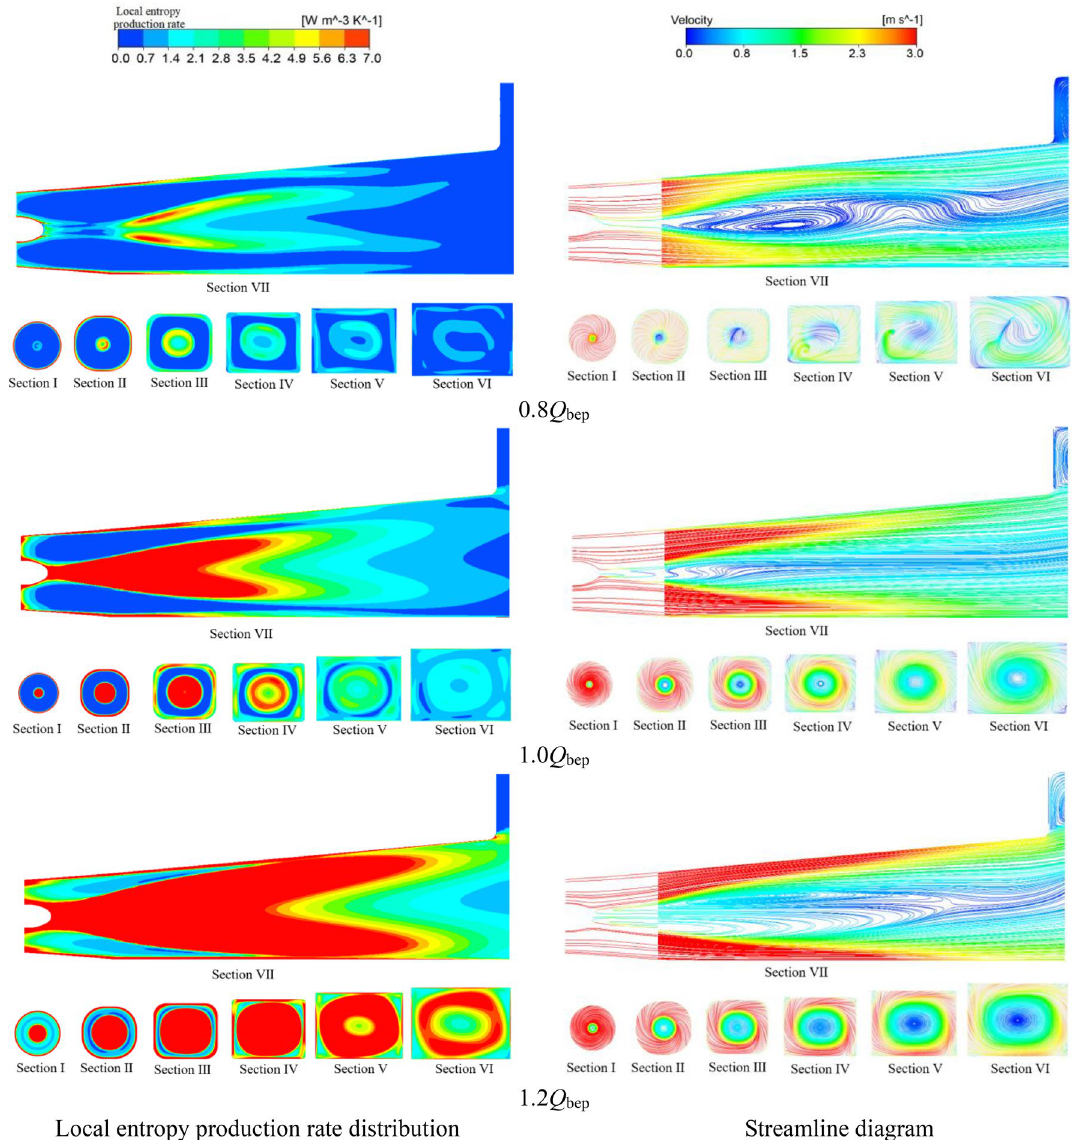
Figure 16. Local entropy production rate distribution and streamline diagrams of typical cross sections of the outlet